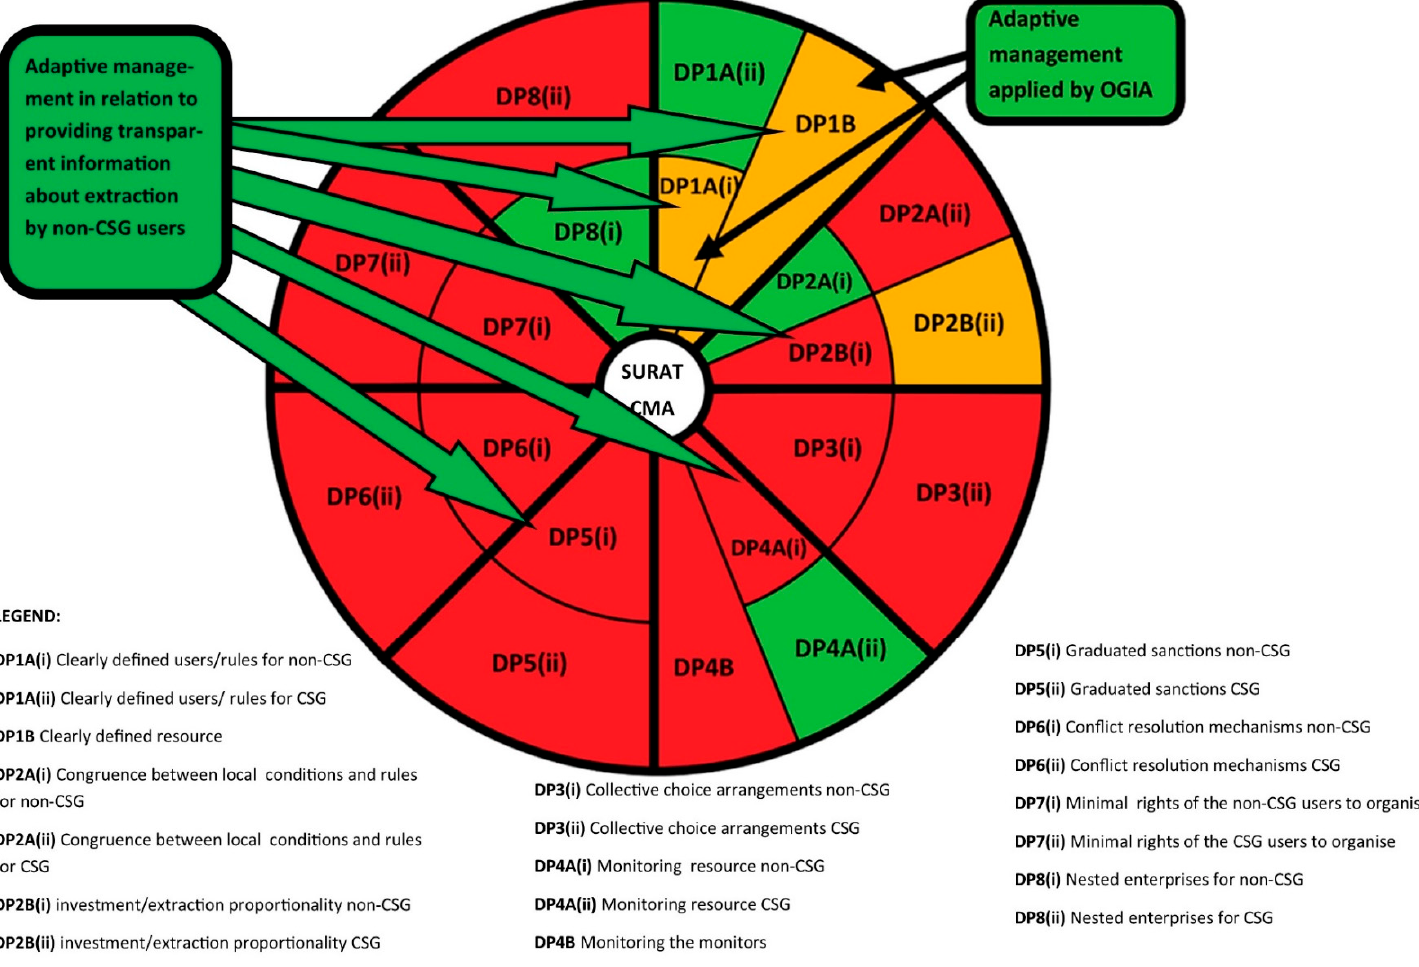
Figure 4. CPR heatmap showing proposed initiative addressing lack of extraction data for non-CSG users.